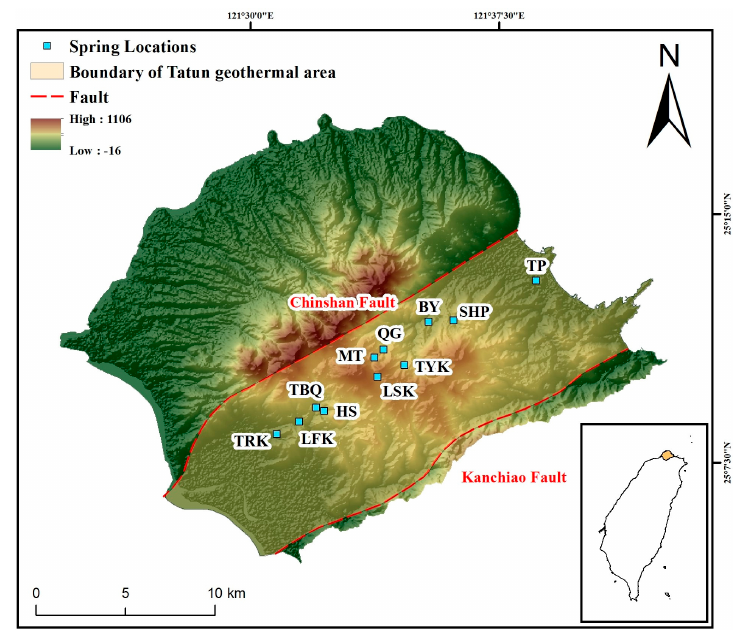
Figure 1. Location map of the springs in the Tatun Volcano Group.